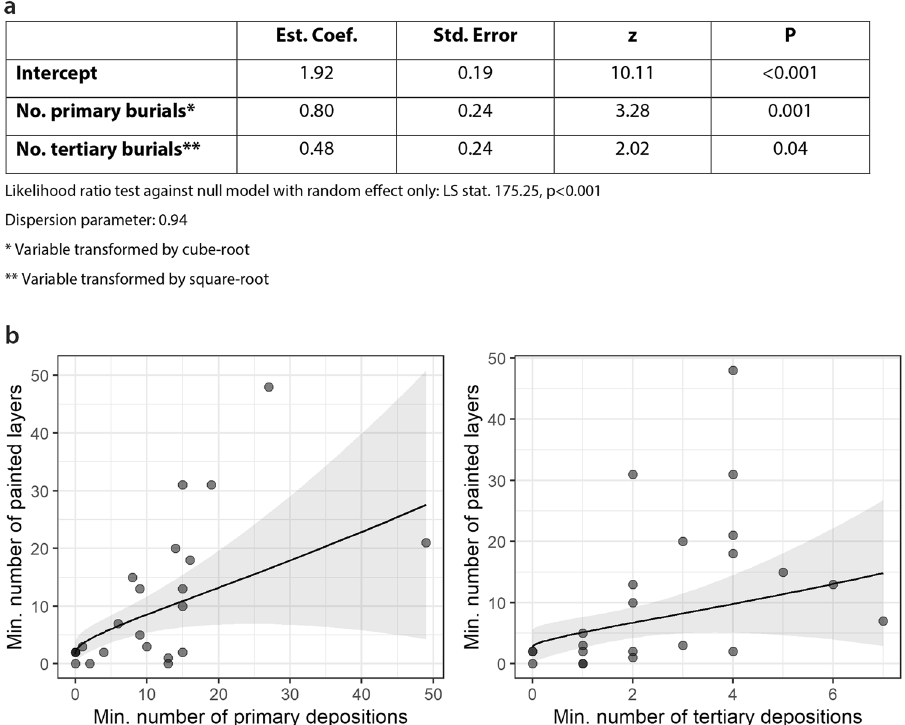
Figure 6. ( a ) Summary of the linear model and the modelled relationships; ( b ) The relationship between primary (left panel)/tertiary (right panel) depositional contexts and the minimum number of painted wall layers. The black solid lines depict the modelled effect of primary and tertiary depositions on the painted layers; the grey area represents the 95% confidence interval of the mean predicted values. Table and graphs generated with R × 64 v4.1.0 (https:// cran.r- proje ct. org/ bin/ windo ws/ base/ old/4. 1.0/) and combined in Adobe illustrator 23.0.6 (http:// www. adobe. com/ fr/ produ cts/ illus trator.